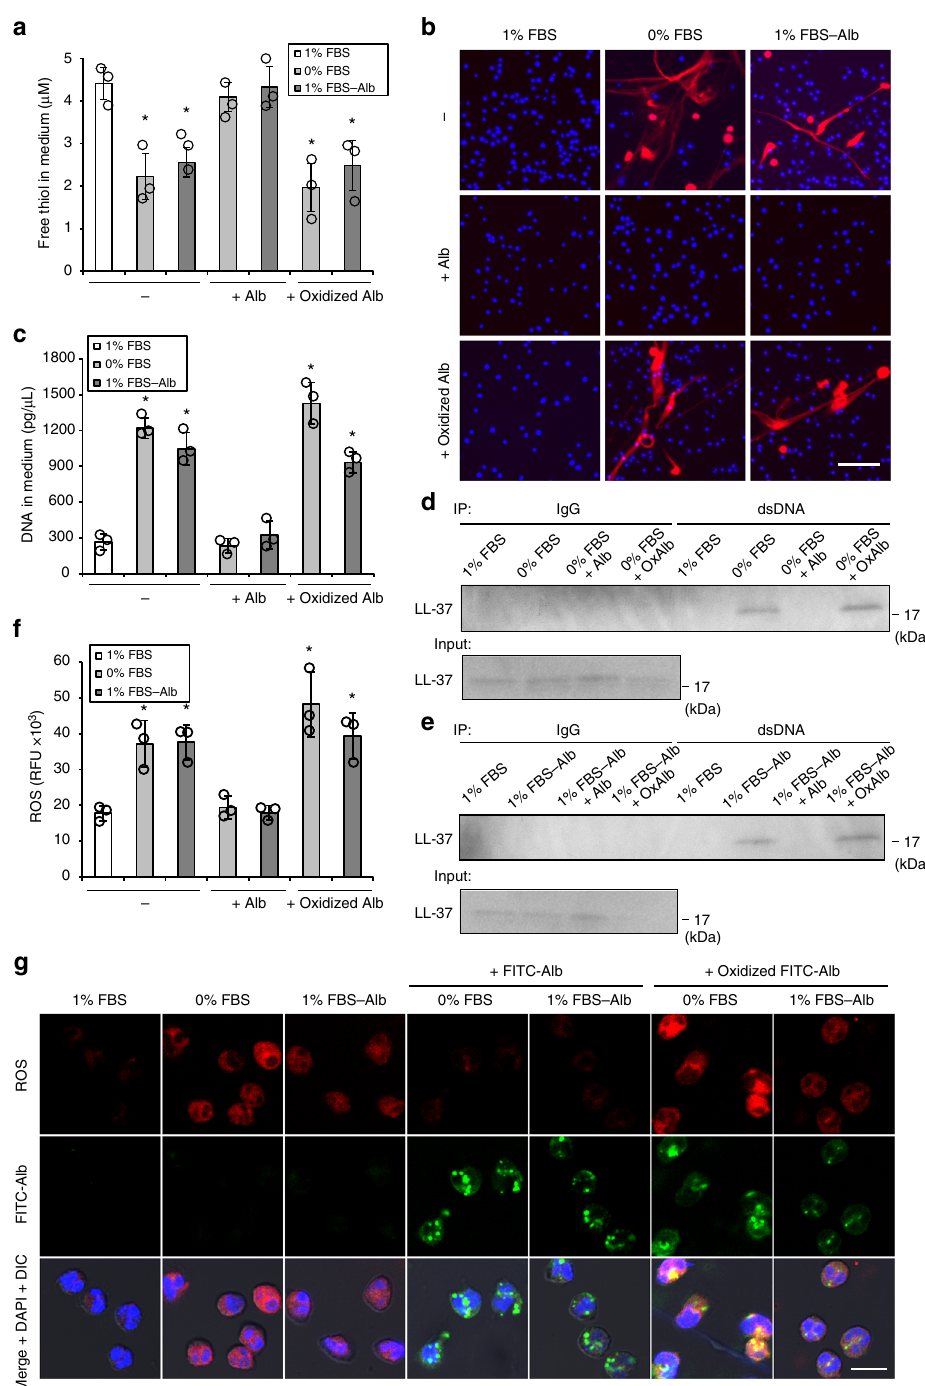
Fig. 1 Albumin oxidation triggers NETosis without in fl ammatory stimuli. a Free thiol concentration in medium containing 1% FBS, 0% FBS, and 1% albumin- depleted FBS (1% FBS-Alb) with or without albumin replenishment ( fi nal concentration: 0.02 g/dL, matching the albumin concentration in the condition of 1% FBS). b – g Human neutrophils were cultured under the conditions of 1% FBS, 0% FBS, and 1% FBS-Alb with or without albumin replenishment for 6 h ( b – e ), 5 min ( f ), or 1 h ( g ). b Representative images of neutrophils stained with cell-permeable DNA dye, Hoechst 33342 (blue), and cell-impermeable DNA dye, SytoxOrange (red). Bar = 50 μ m. c Concentration of extracellular DNA within culture medium. d , e Detection of LL-37 physically associated with extracellular DNA within culture medium. Extracellular DNA was immunoprecipitated from culture medium using an anti-dsDNA antibody or IgG isotype control, and the isolated DNA (or the input culture medium without immunoprecipitation) was subjected to Western blotting for LL-37. f Intracellular ROS levels within human neutrophils in the indicated culture conditions. g Representative images of intracellular ROS and albumin in neutrophils. Intracellular ROS was stained by CellROX Deep Red Reagent. Albumin internalization by neutrophils was visualized using albumin- fl uorescein isothiocyanate conjugate (FITC-Alb). Bar = 10 μ m. a , c , f Results represent individual values with the mean ± s.d. ( n = 3; biological replicates, signi fi cant differences were compared with control at * P < 0.05 by Dunnett ’ s